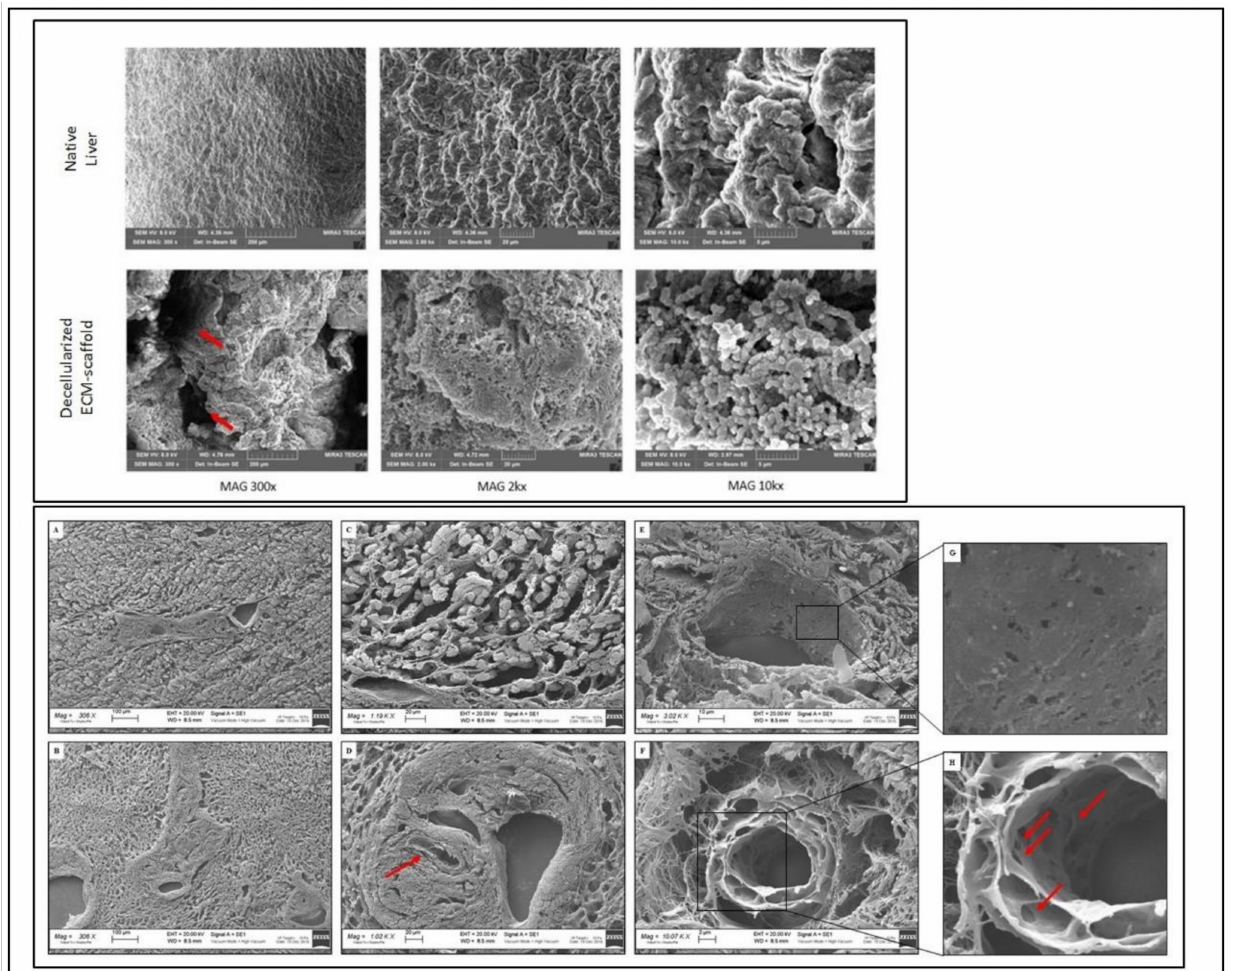
Figure 3. Upper panel: Scanning Electron Microscopy (SEM) of the native and decellularised scaffold at different magnifications (300 × , 2k × and 10k × ). SEM analysis of the acellular ECM showed a rough surface and preserved three-dimensional structures characterised by highly interconnected porosity (arrows = vessel tracts). Lower panel ( A – F ): SEM images of decellularised ECM-scaffold slides showing the complete cellular removal and the 3D preservation of the ultrastructure after decellularisation (arrows = vessel tracts). Details are highlighted ( G , H